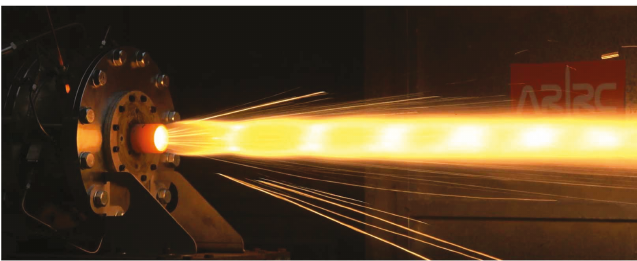
Figure 13: Snapshot of the 250 class DVF engine during operation.